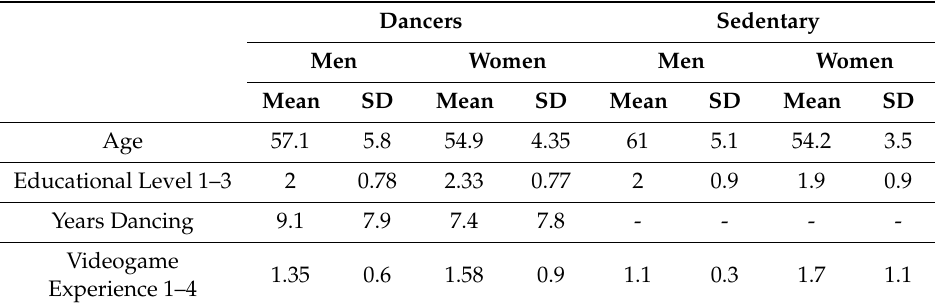
Table 1. Characteristics of the sample (mean + SD). Dancers Sedentary